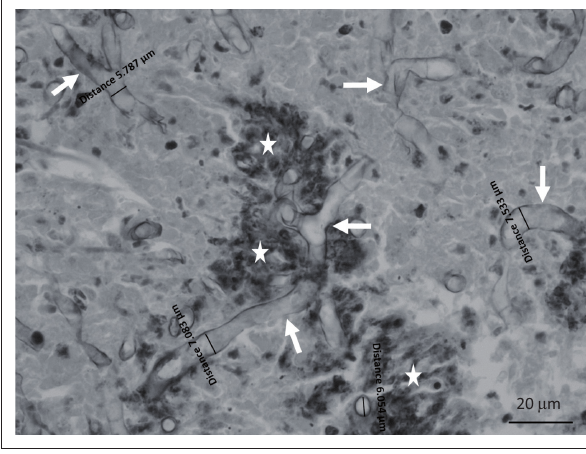
FIGURE 1: Hyper-eosinophilic Splendore-Hoeppli foreign material (circle) surrounded by large numbers of multinucleate giant macrophages (arrows) characteristic of the chronic inflammatory reaction associated with fungal infections.